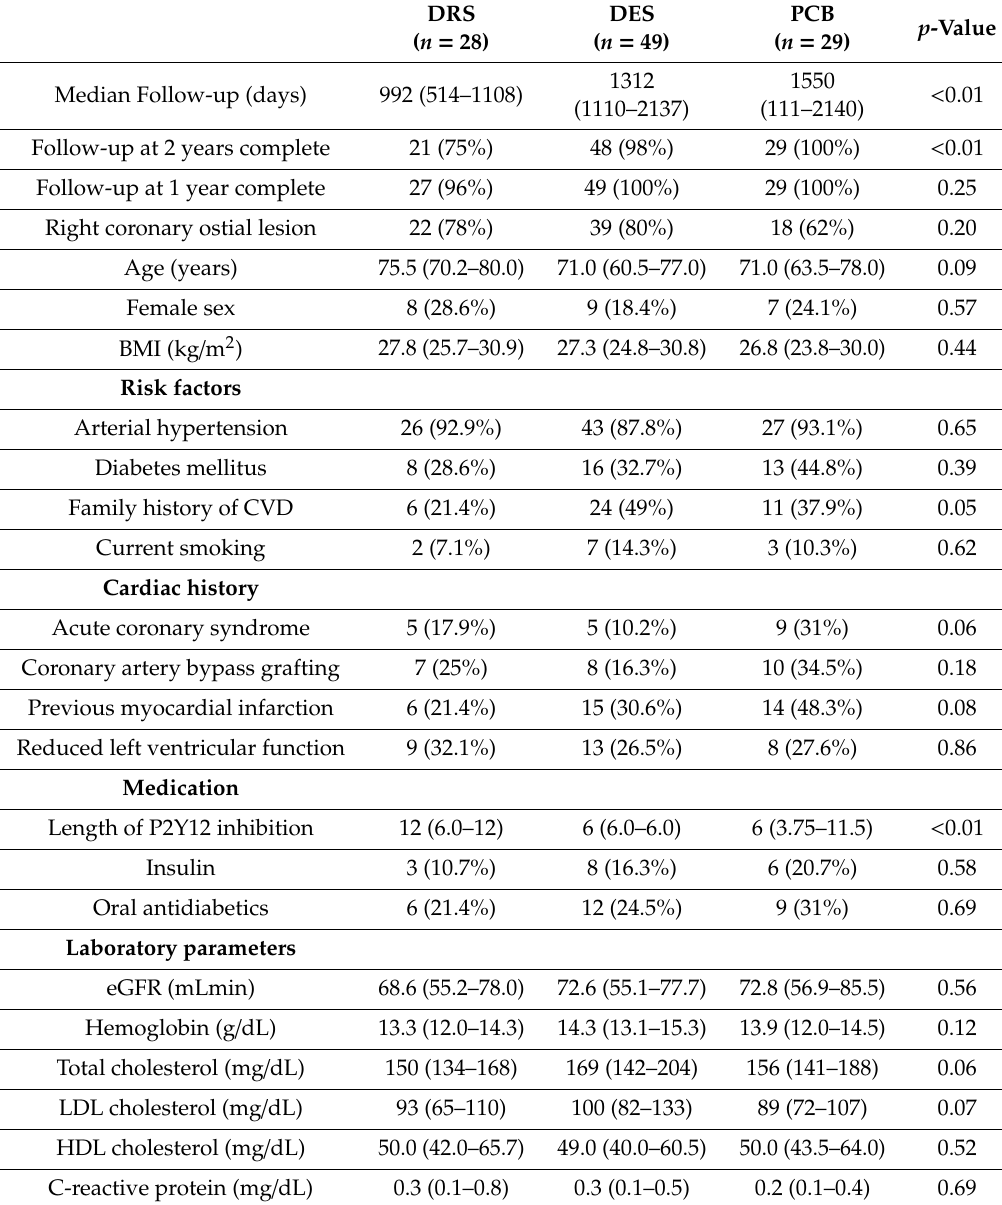
Table 1. Patient